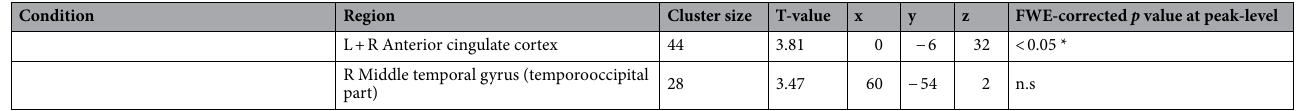
Table 2. Results of the comparison between CT-targeted versus non-CT-targeted stimulation of the penile shaft, CT-targeted and non-CT-targeted penile shaft versus frenulum stimulation and CT-targeted versus non-CT-targeted forearm stimulation. Only activity with a peak-level uncorrected p value < 0.001 and minimal cluster size of (k = 20) is reported. Regions were defined with the Harvard–Oxford Cortical Atlas. * Indicates that the cluster was only significant at an FWE-corrected threshold after applying small-volume correction (SVC). The SVC was applied for a mask containing all regions-of-interest (ROI’s). See Methods-section for more detail on ROI definition. Abbreviations: n.s., non-significant; R, right hemisphere; L, left hemisphere.